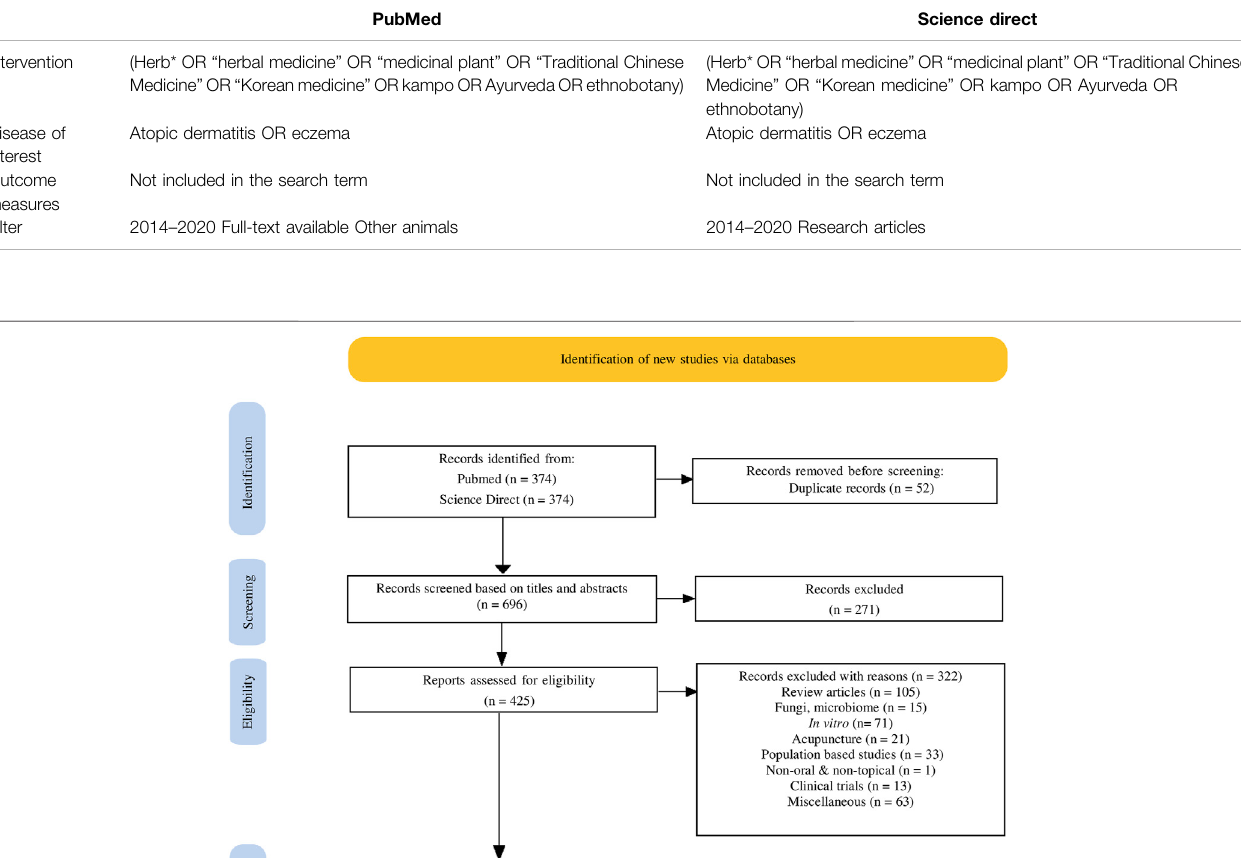
Frontiers in Pharmacology |